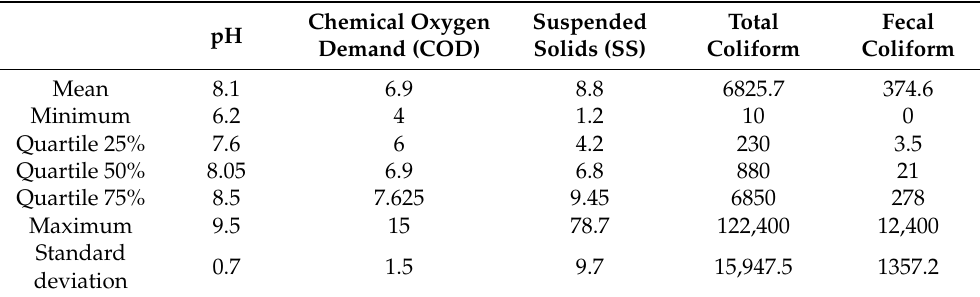
Table 2. Water quality of the Nakdong River during the pilot plant operation period (1 January 2016–31 December 2017) [23].